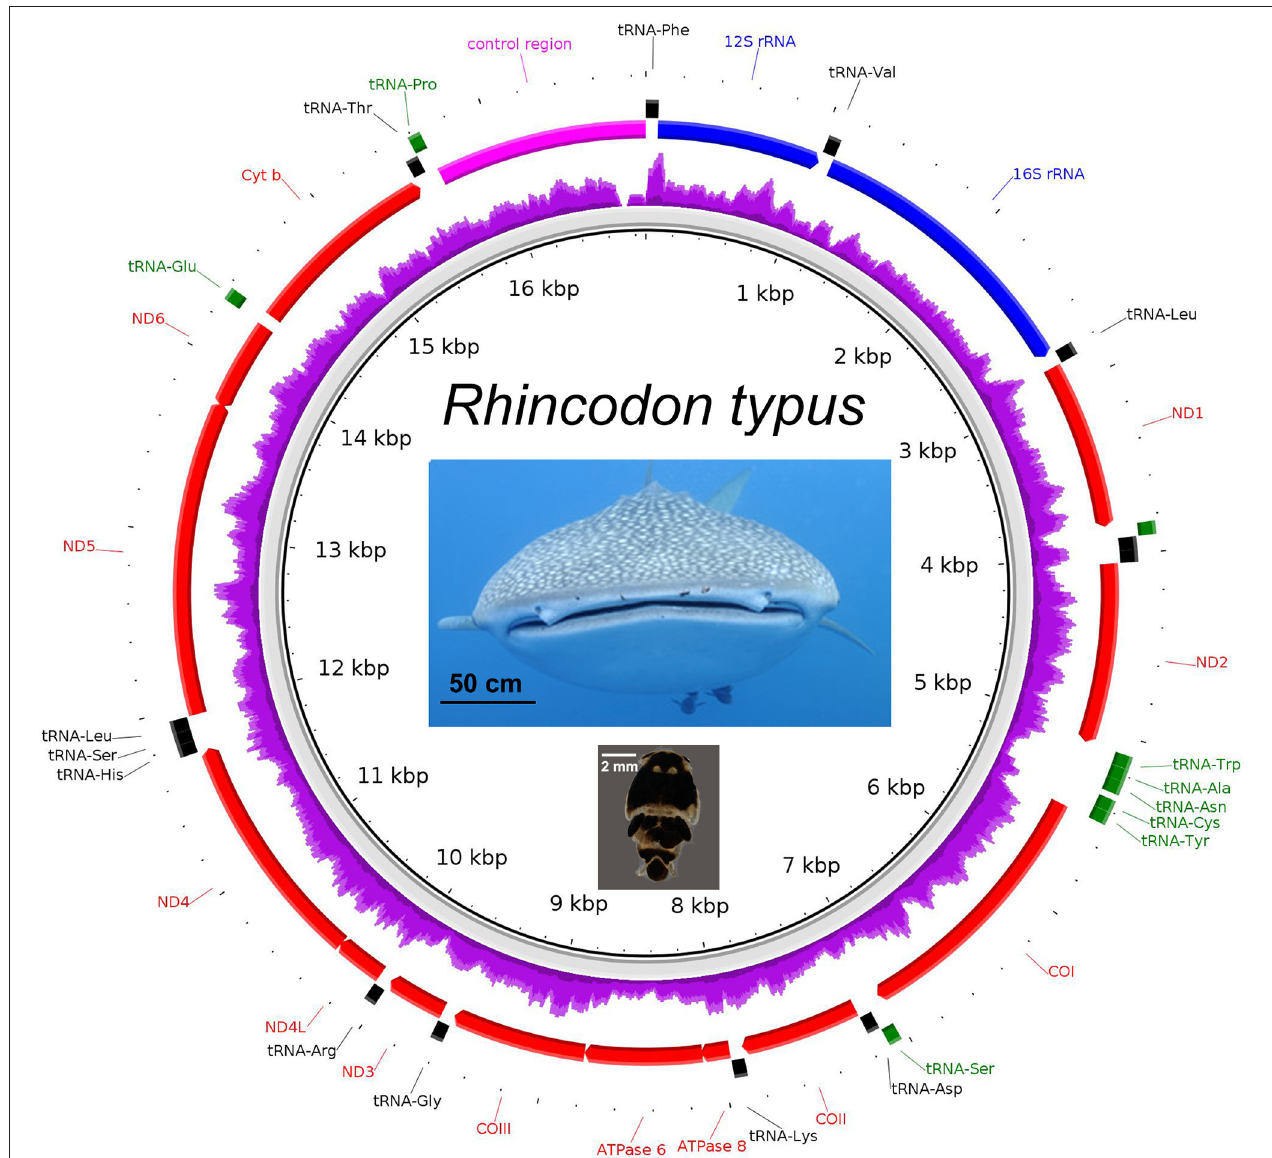
FIGURE 4 | The mitogenome of Rhincodon typus (upper photo—note copepod parasites Pandarus rhincodonicus visible as black dots near the center of the upper lip) recovered from the shotgun sequencing of the parasitic copepod, P. rhincodonicus (lower photo). The purple ring indicates relative mapping coverage, and the transcriptional orientation of each protein coding gene is indicated by the red